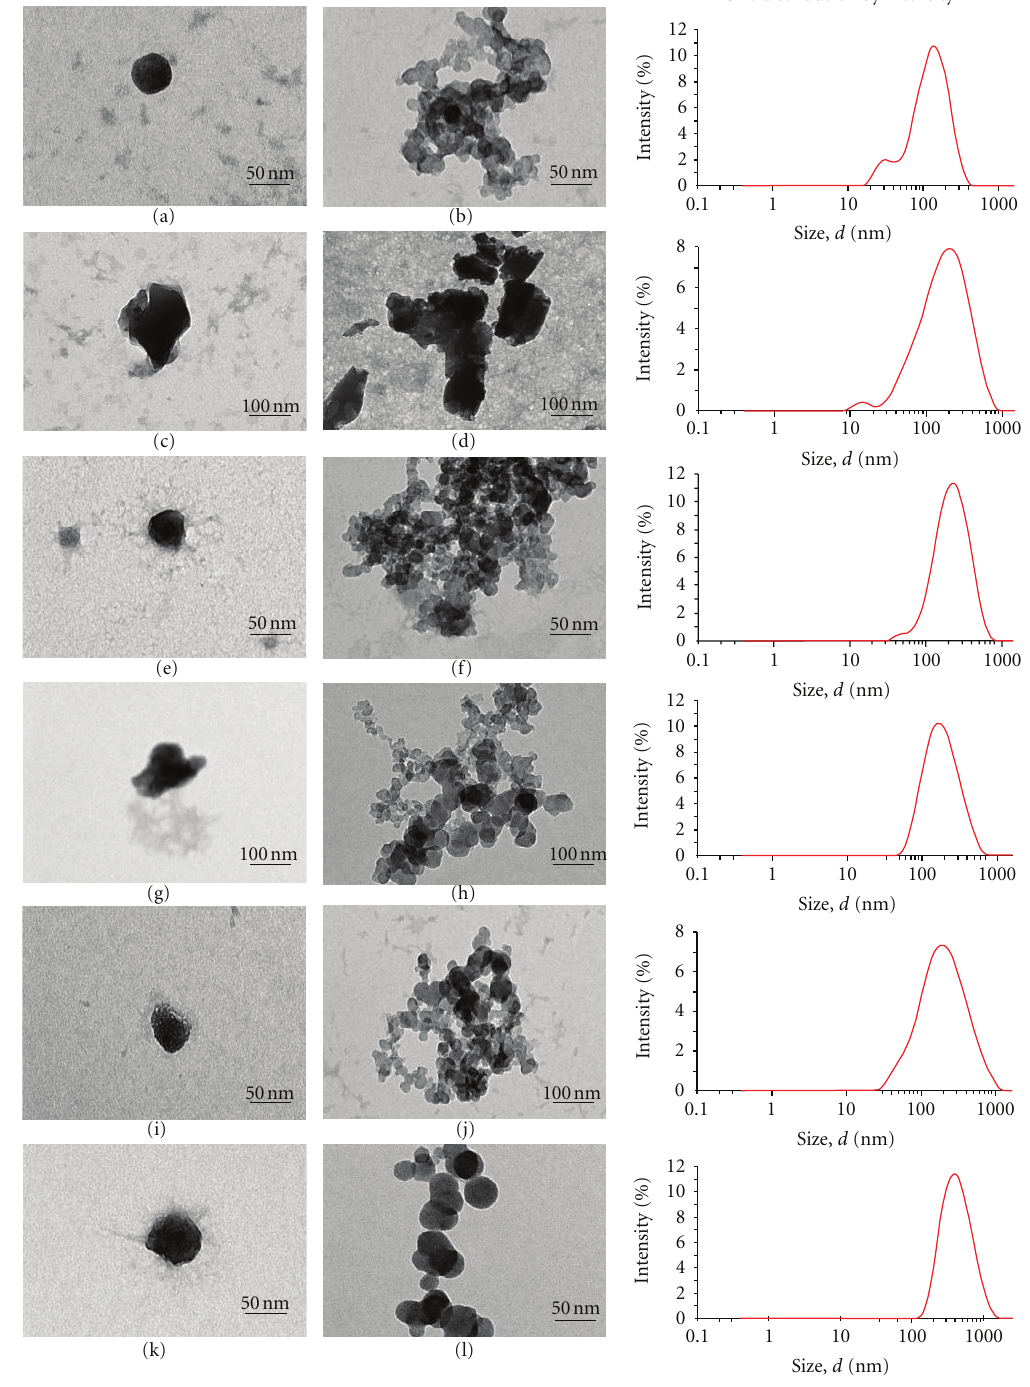
Figure 1: Top: TEM images and particle size distribution of LMW (a, b), HMW (c, d), and TMC (e, f) nanoparticles before centrifugation. Bottom: TEM images and particle size distribution of LMW (g, h), HMW (i, j), and TMC (k, l) nanoparticles after centrifugation. Nanoparticles were prepared from chitosan concentration of